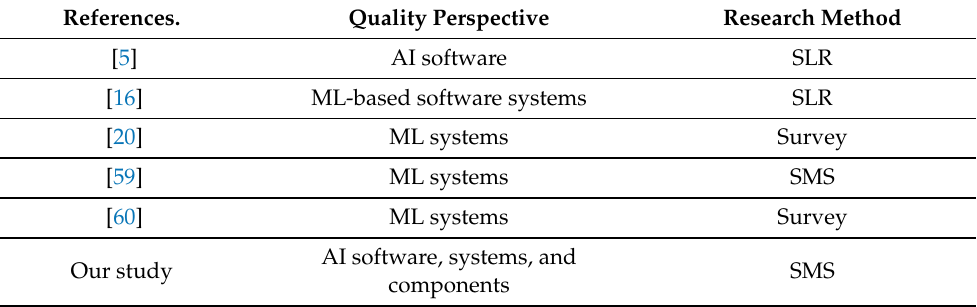
Table 1. Comparison of Related Works.